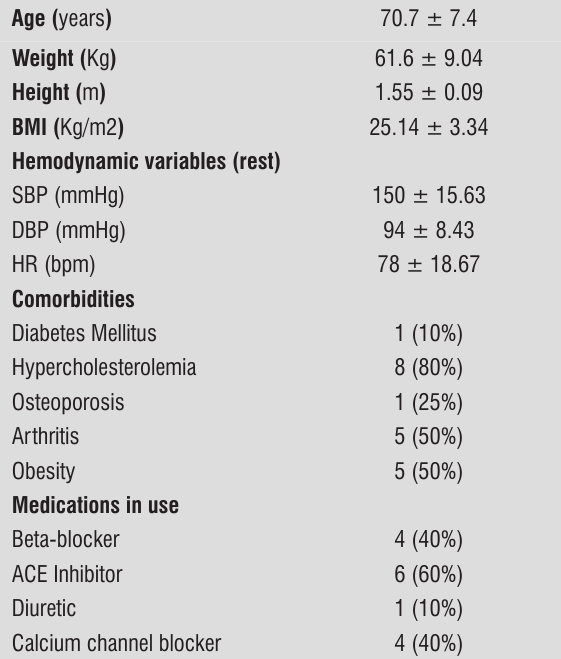
Table 1 - General characteristics of the study